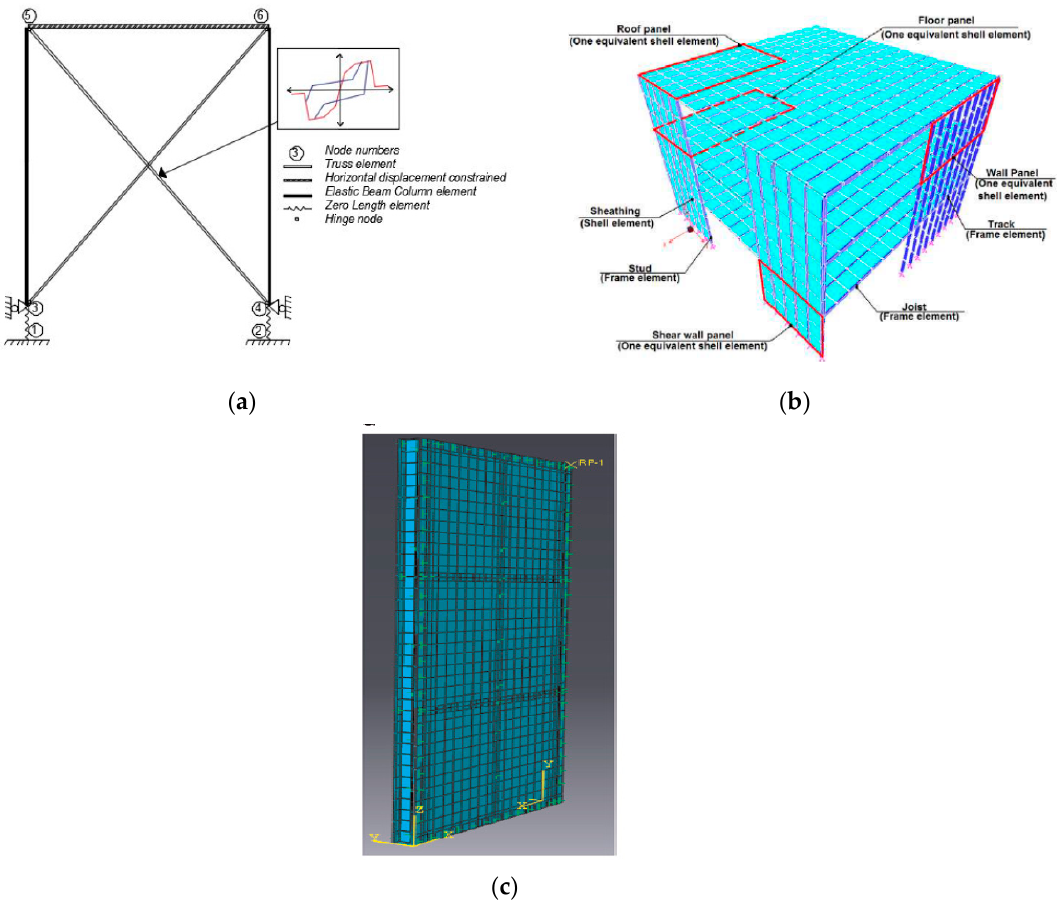
Figure 12. ( a ) Equivalent truss finite element model [49]; ( b ) equivalent shell finite element models [52]; ( c ) detailed finite element model [31].